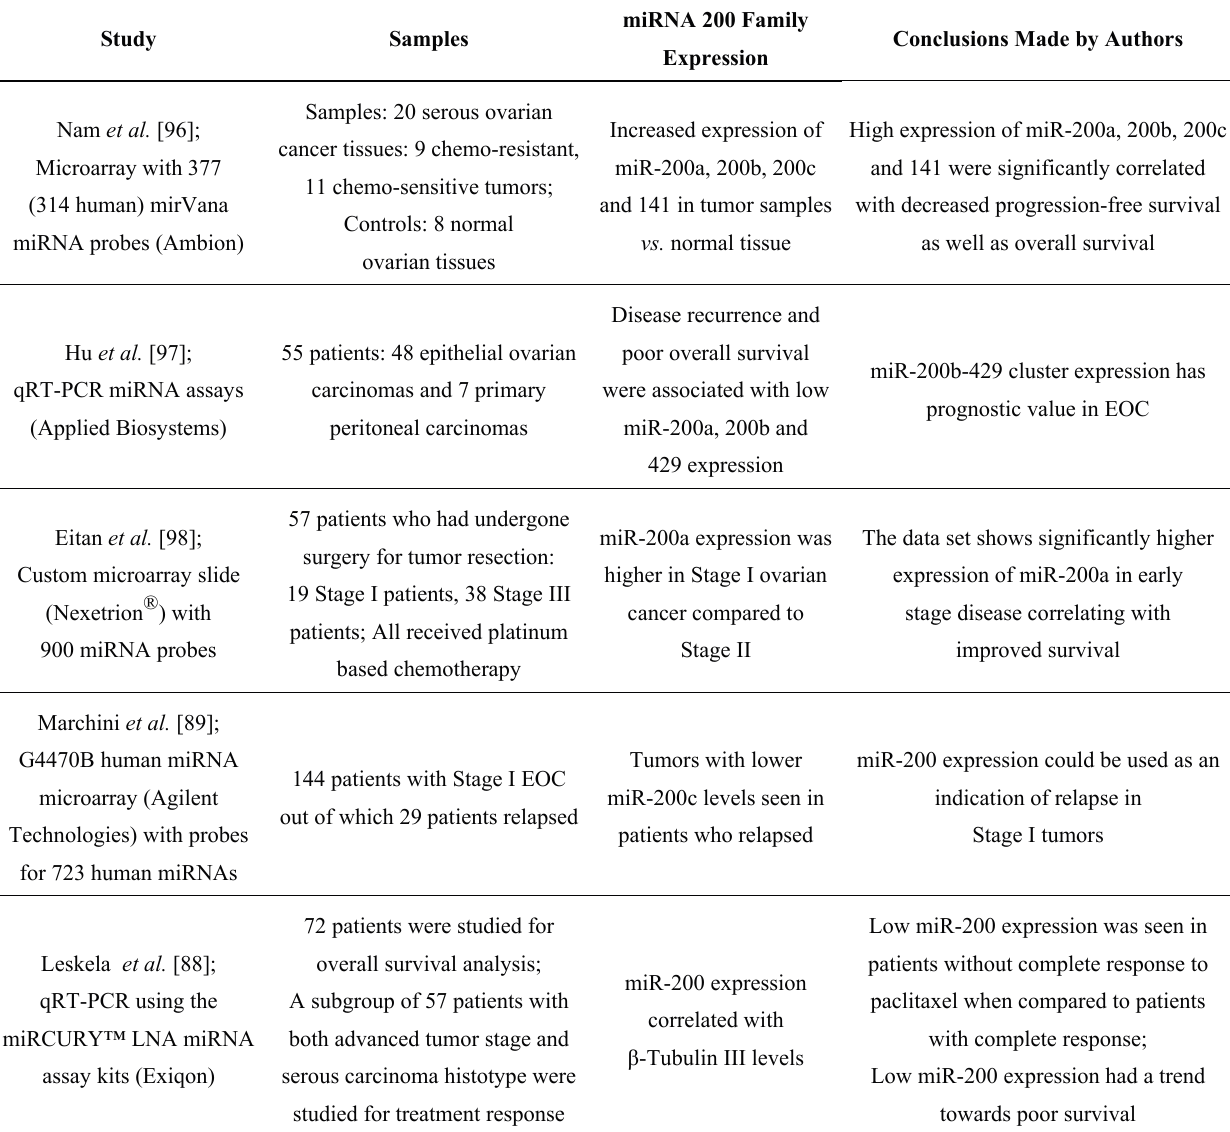
Table 2. Predictive value of miRNA-200 family expression for disease